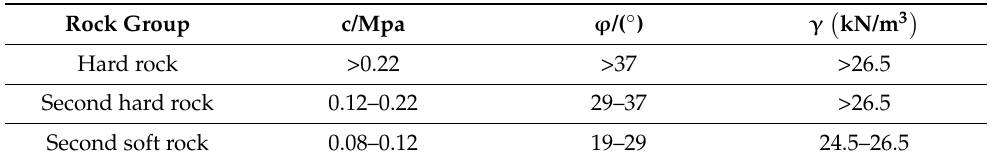
Table 2. Classification of engineering rock mass grade and its parameter value (GB50218T-2014,